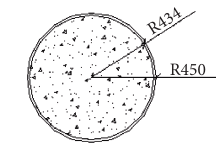
Figure 4: III-III section (unit: mm).